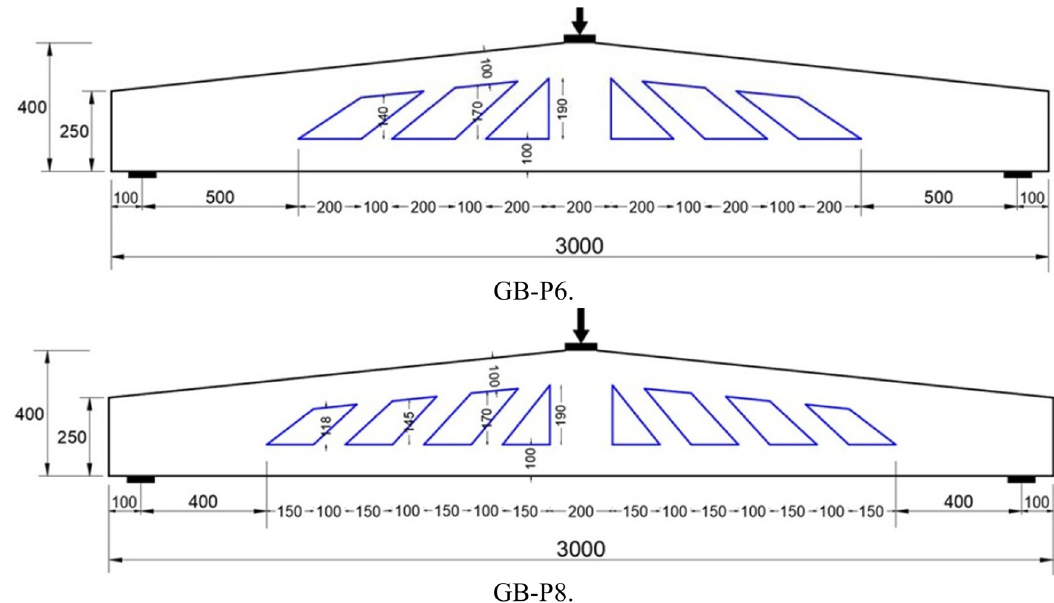
Figure 3: An architecture of group B ( all dimensions are in mm )